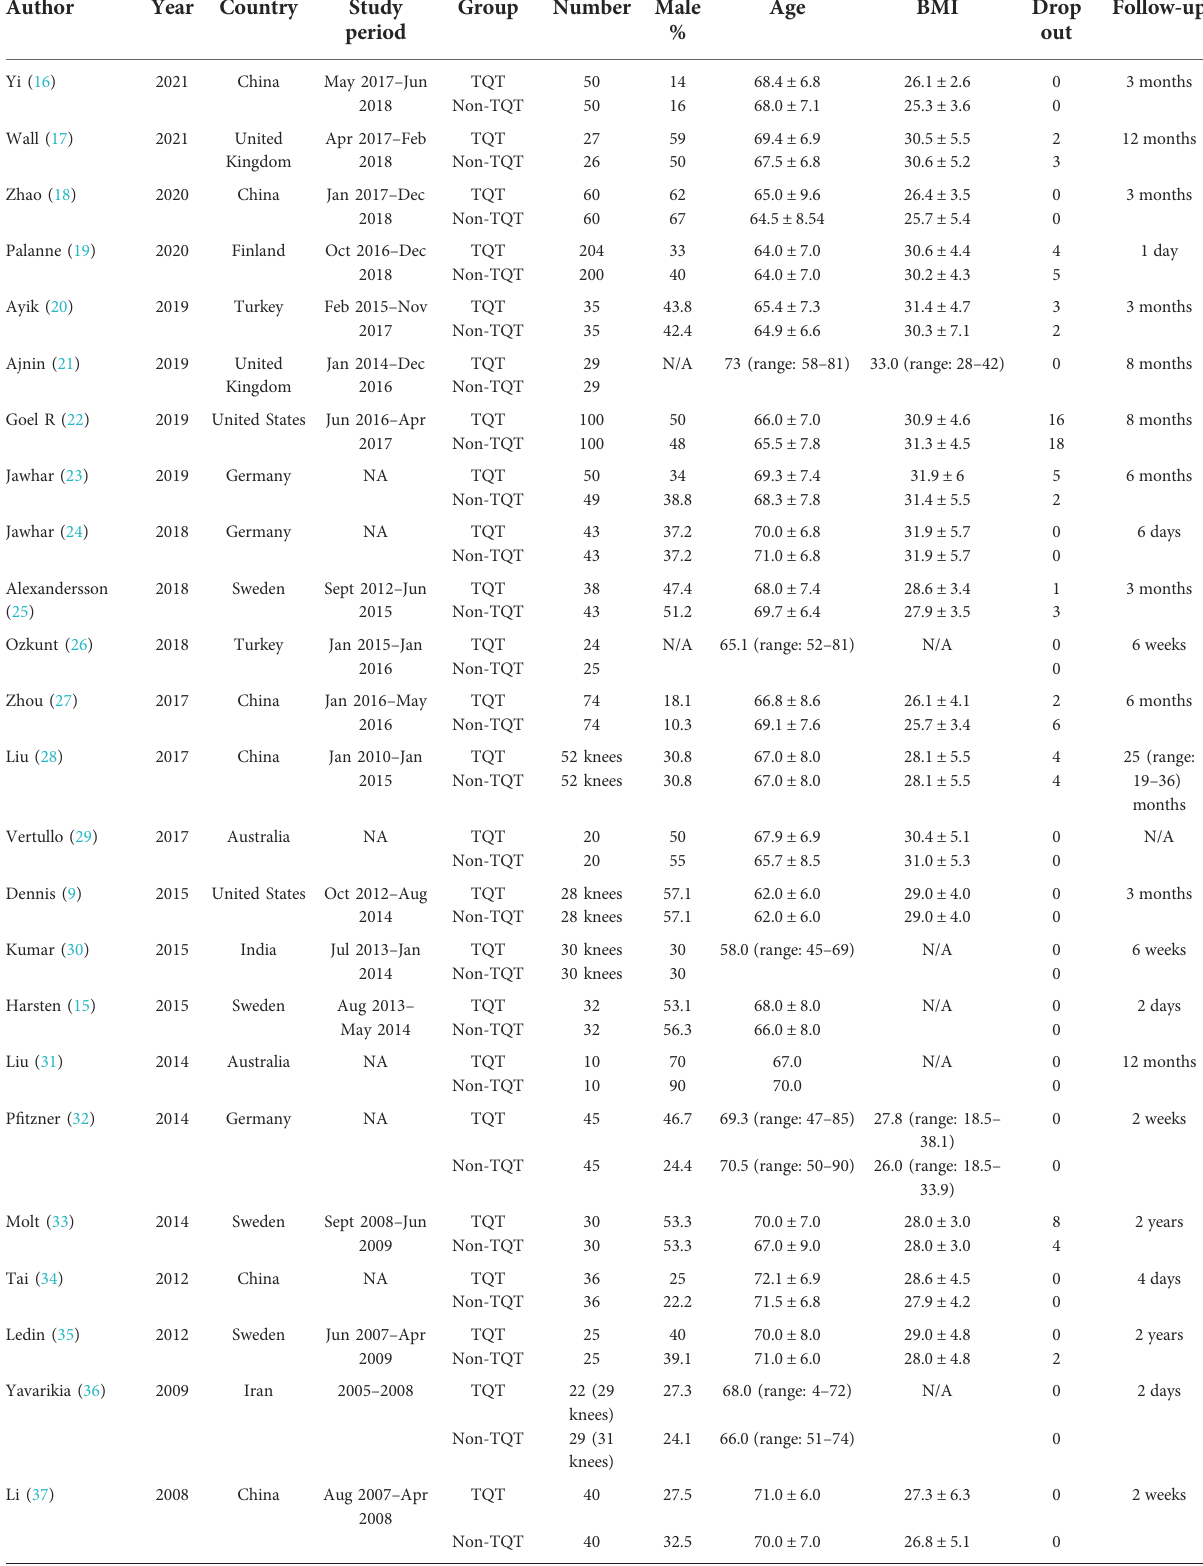
TABLE 1 Characteristics of the included